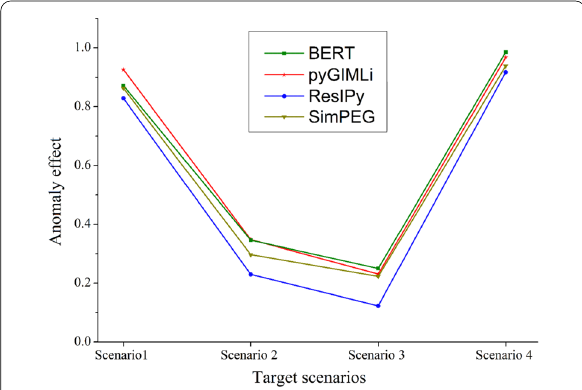
Fig. 7 The anomaly effect of the pyGIMLi, BERT, SimPEG, and ResIPy freeware for simulated buried